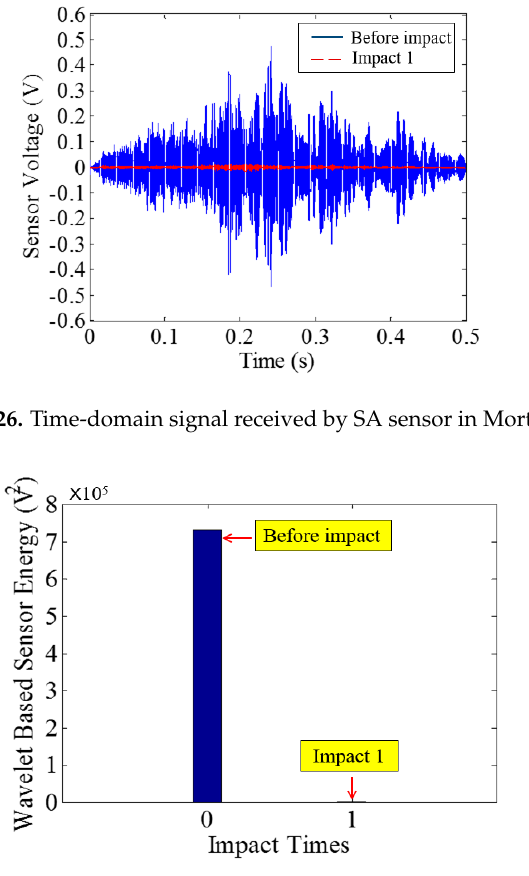
Figure 25 . Results of crack detection of Mortar-3 with high-speed video.